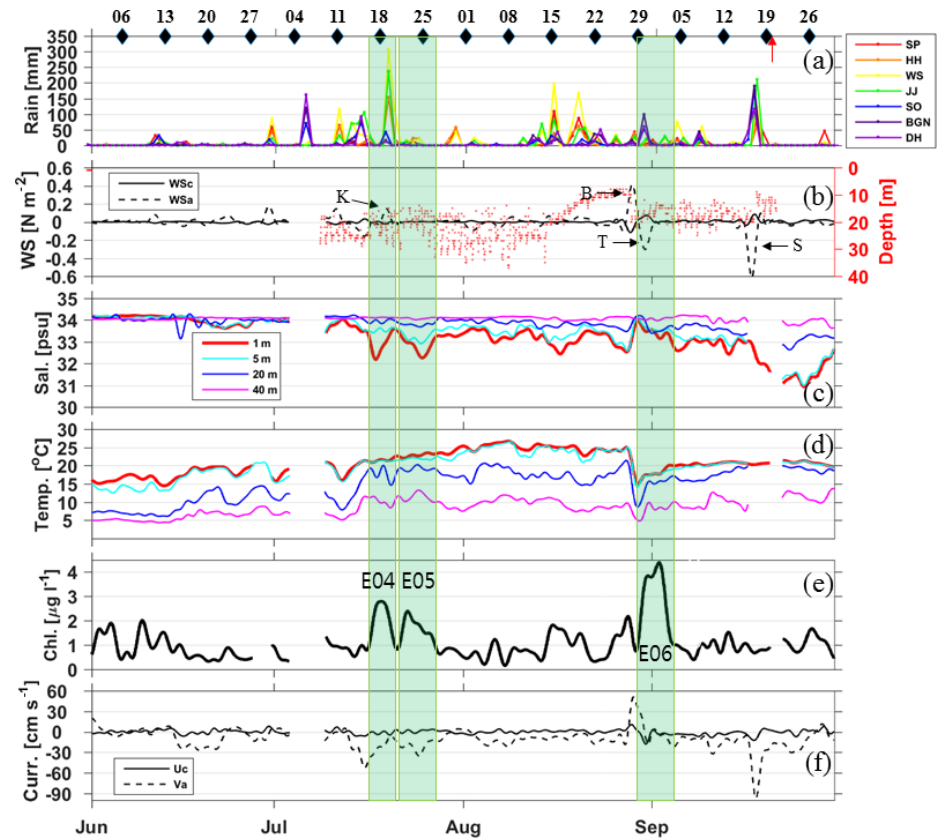
Figure 6. Same as Fig. 5, but for the 2012 bloom events labeled E04 to E06, and four typhoons (K: Khanun, T: Tenbin, B: Bolaven, S: Sanba). Euphotic depths ( Z eu , red dots) derived from two PAR sensors attached to the ESROB are superimposed in (b)